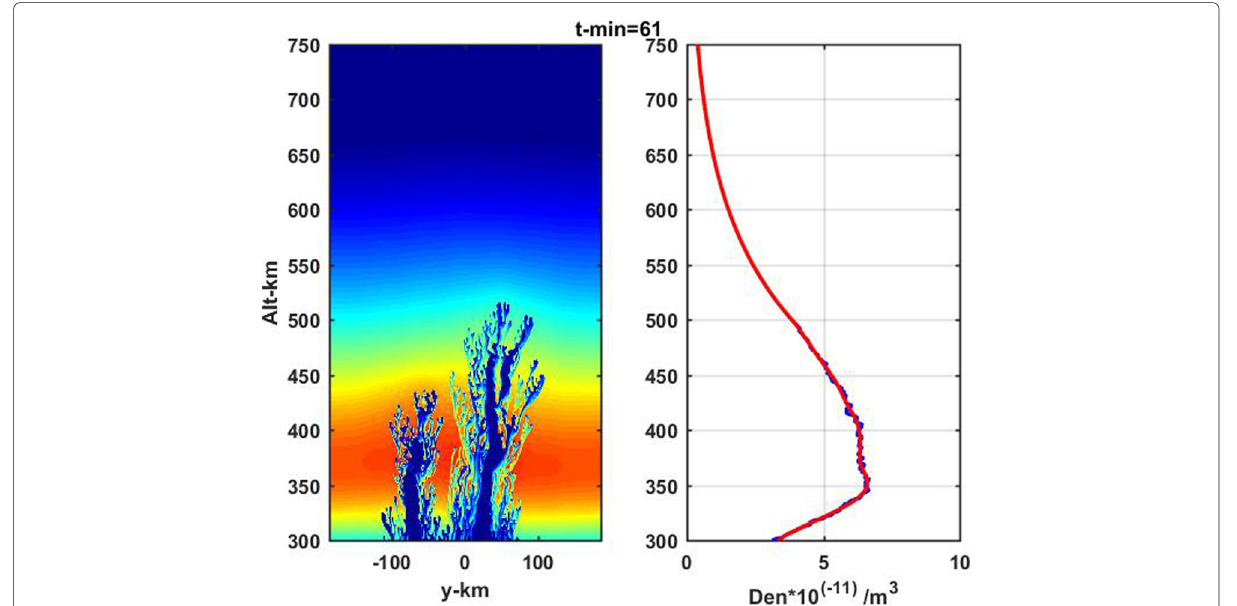
Fig. 5 The left frame shows the offset2 plane structure at 1 h. The right frame shows the path-integrated density (blue) with a smoothed profile overlaid